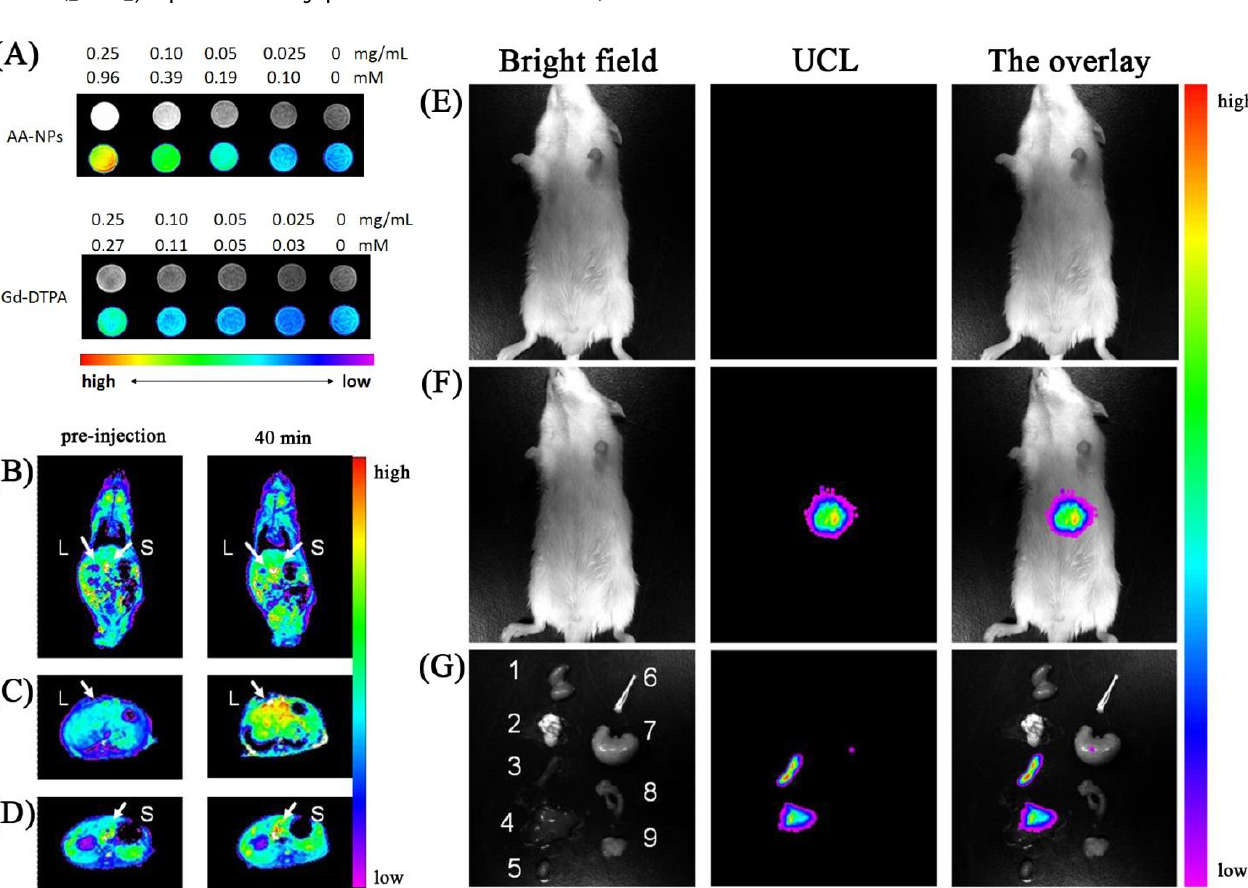
Figure 18. (Left column, A ): T1-weighted and color-mapped MR images for different mass and molar concentrations of (top) AA-NPs and (bottom) Gd-DTPA. (Left column-bottom): Color-mapped ( B ) coronal images of the whole body and ( C , D ) transversal cross-sectional images of the liver (L) and spleen (S) of mice at pre-injection and at 40 min after intravenous injection of AA-NPs. (Right column): In vivo imaging of mouse after intravenous injection ( E ) with and ( F ) without AA-NPs. ( G ) images of dissected organs of a mouse sacrificed 40 min after intravenous injection with AA-NPs. 1, kidney; 2, lung; 3, spleen; 4, liver; 5, heart; 6, bone; 7, stomach; 8, intestines; 9, muscle ([117], reproduced by permission of